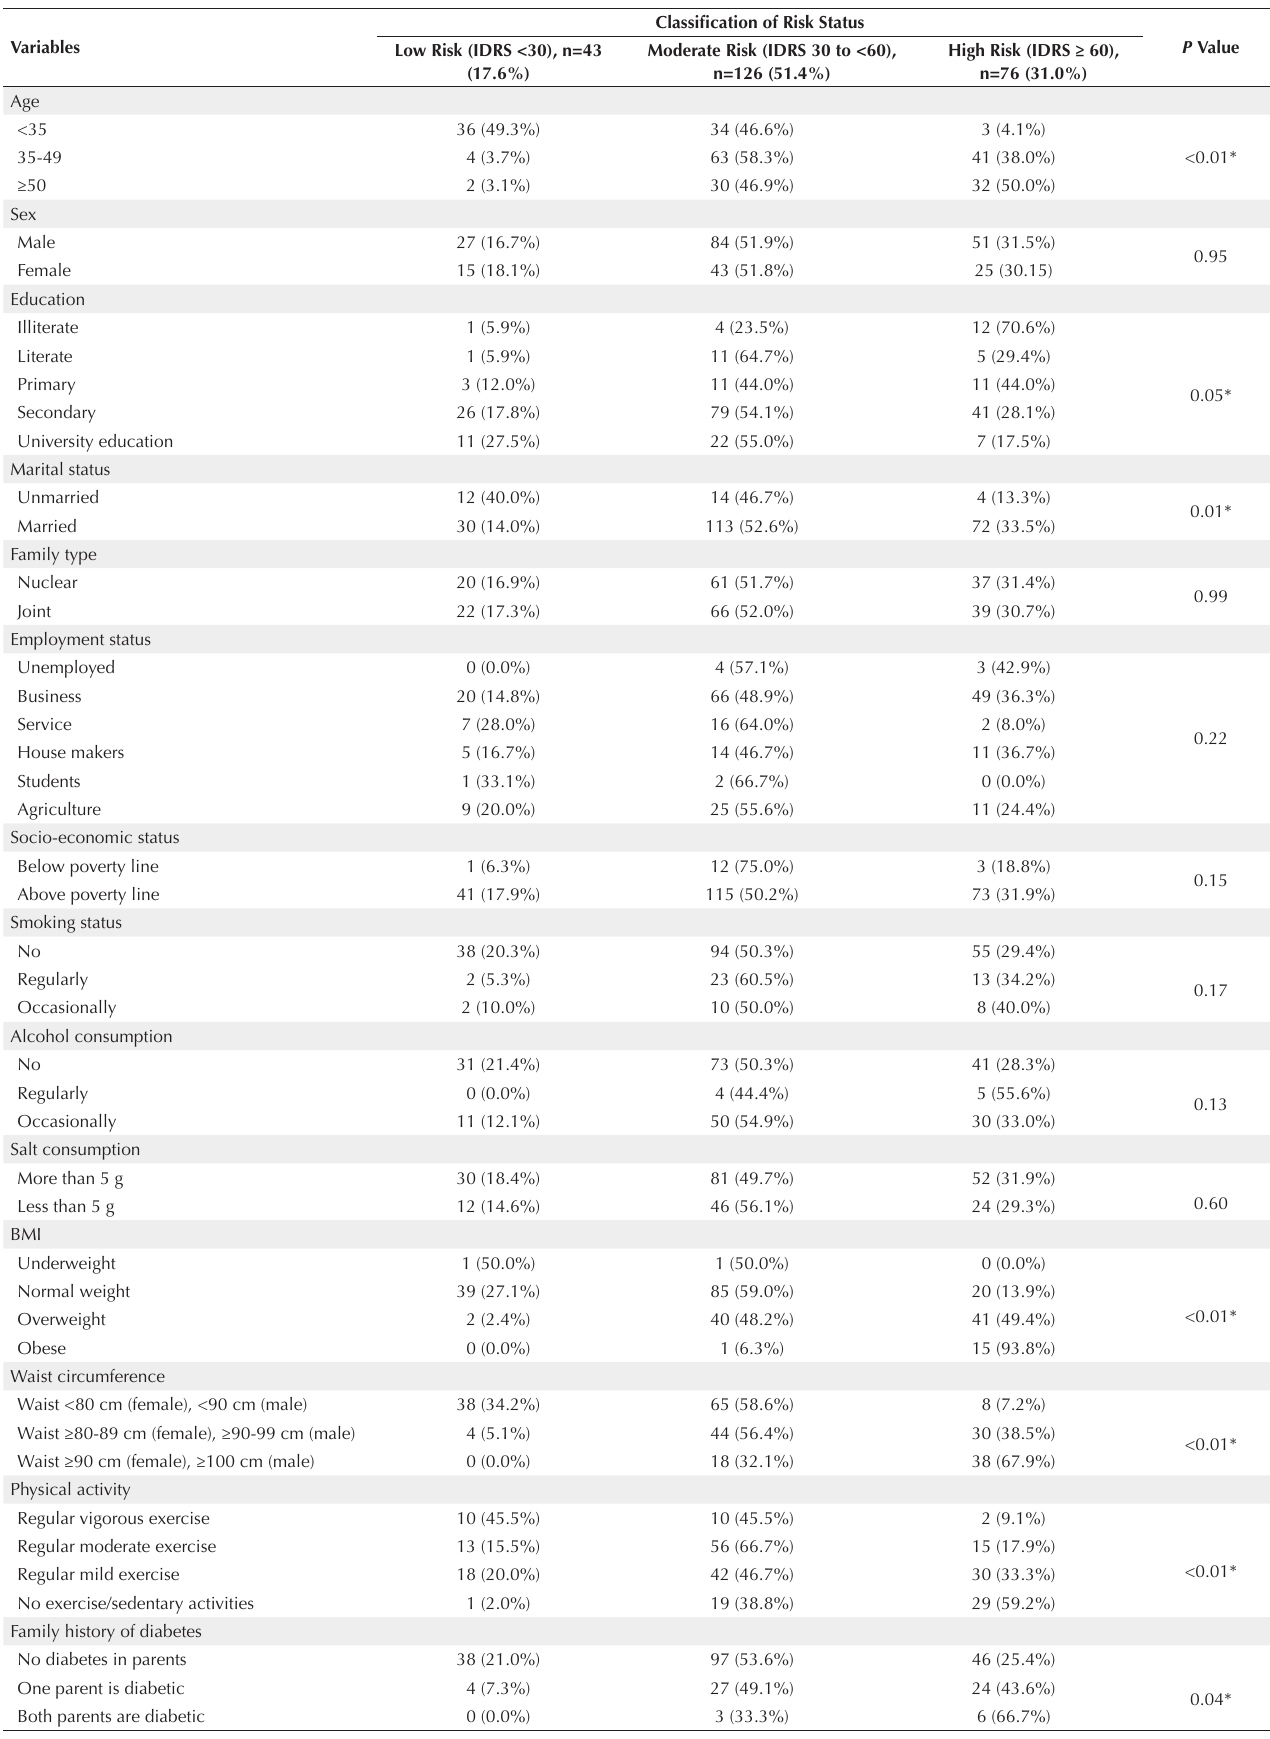
Table 3. Association Between Risk Factors and Risk of Type 2 Diabetes